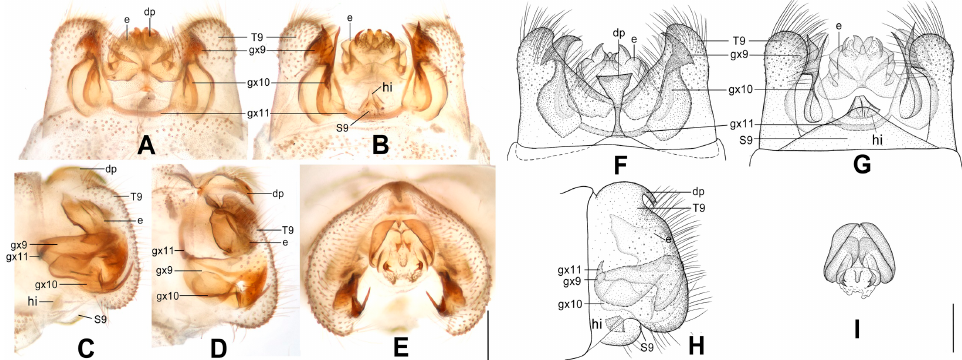
Figure 15. Dilar zhangweiae sp. nov. ( A – E ) male holotype, genitalia, photographs: ( A ) dorsal view; ( B ) ventral view; ( C ) lateral view; ( D ) dorsolateral view; ( E ) caudal view. ( F – I ) male holotype, gen- italia, line drawings: ( F ) dorsal view; ( G ) ventral view; ( H ) lateral view; ( I ) ectoproct, caudal